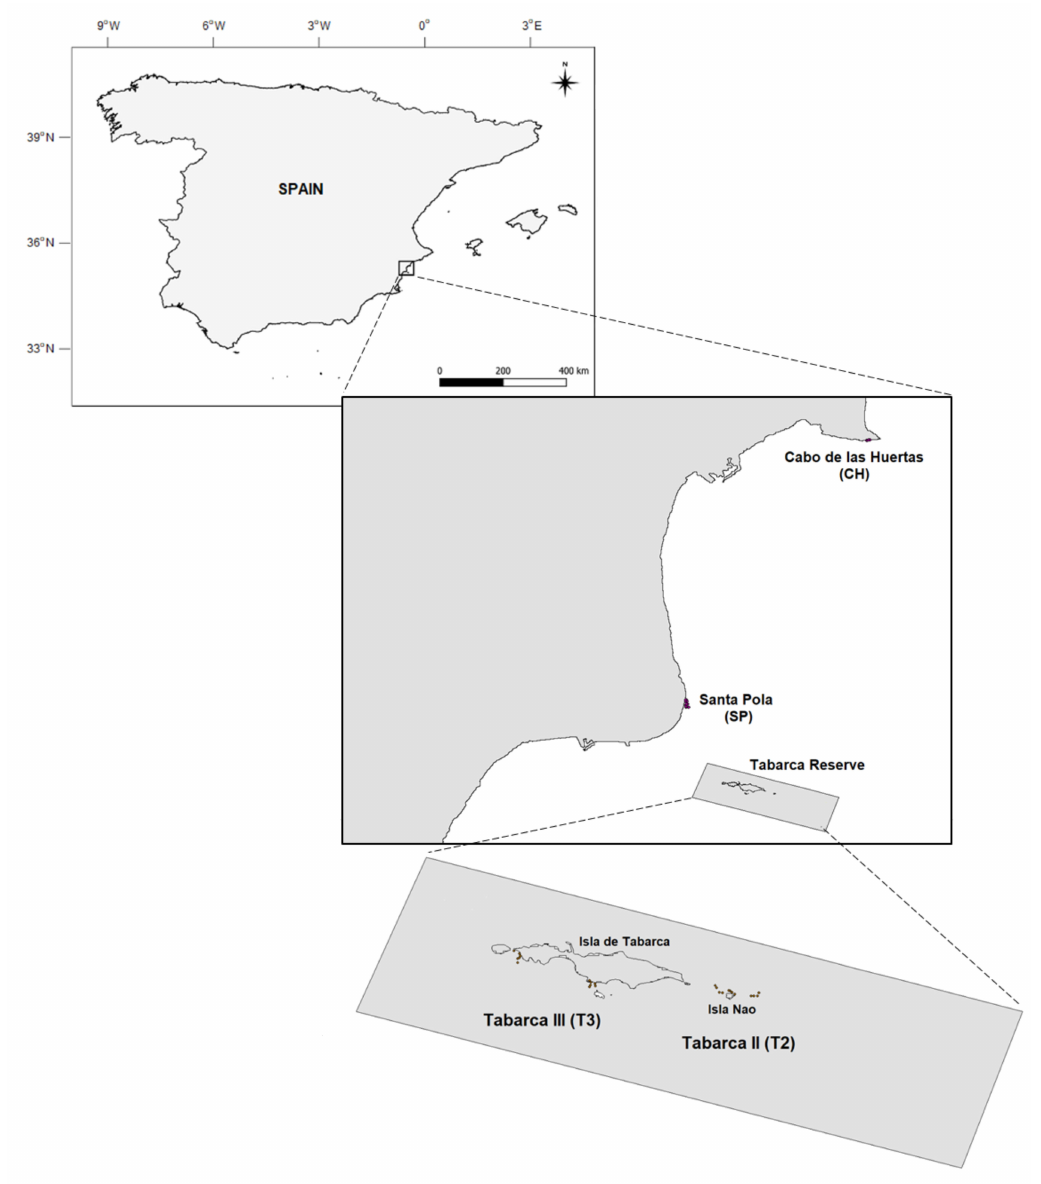
Figure 1. Map of the Alicante region of the Spanish coast, including sampling sites (dots) at Cabo de las Huertas (CH), Santa Pola (SP), and the Tabarca marine reserve ( Isla Nao—T2 and Isla de Tabarca